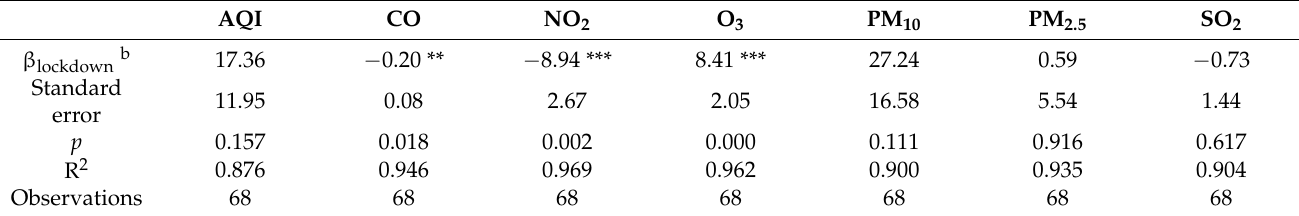
Table 3. The effects of lockdown on air pollutants and the AQI a